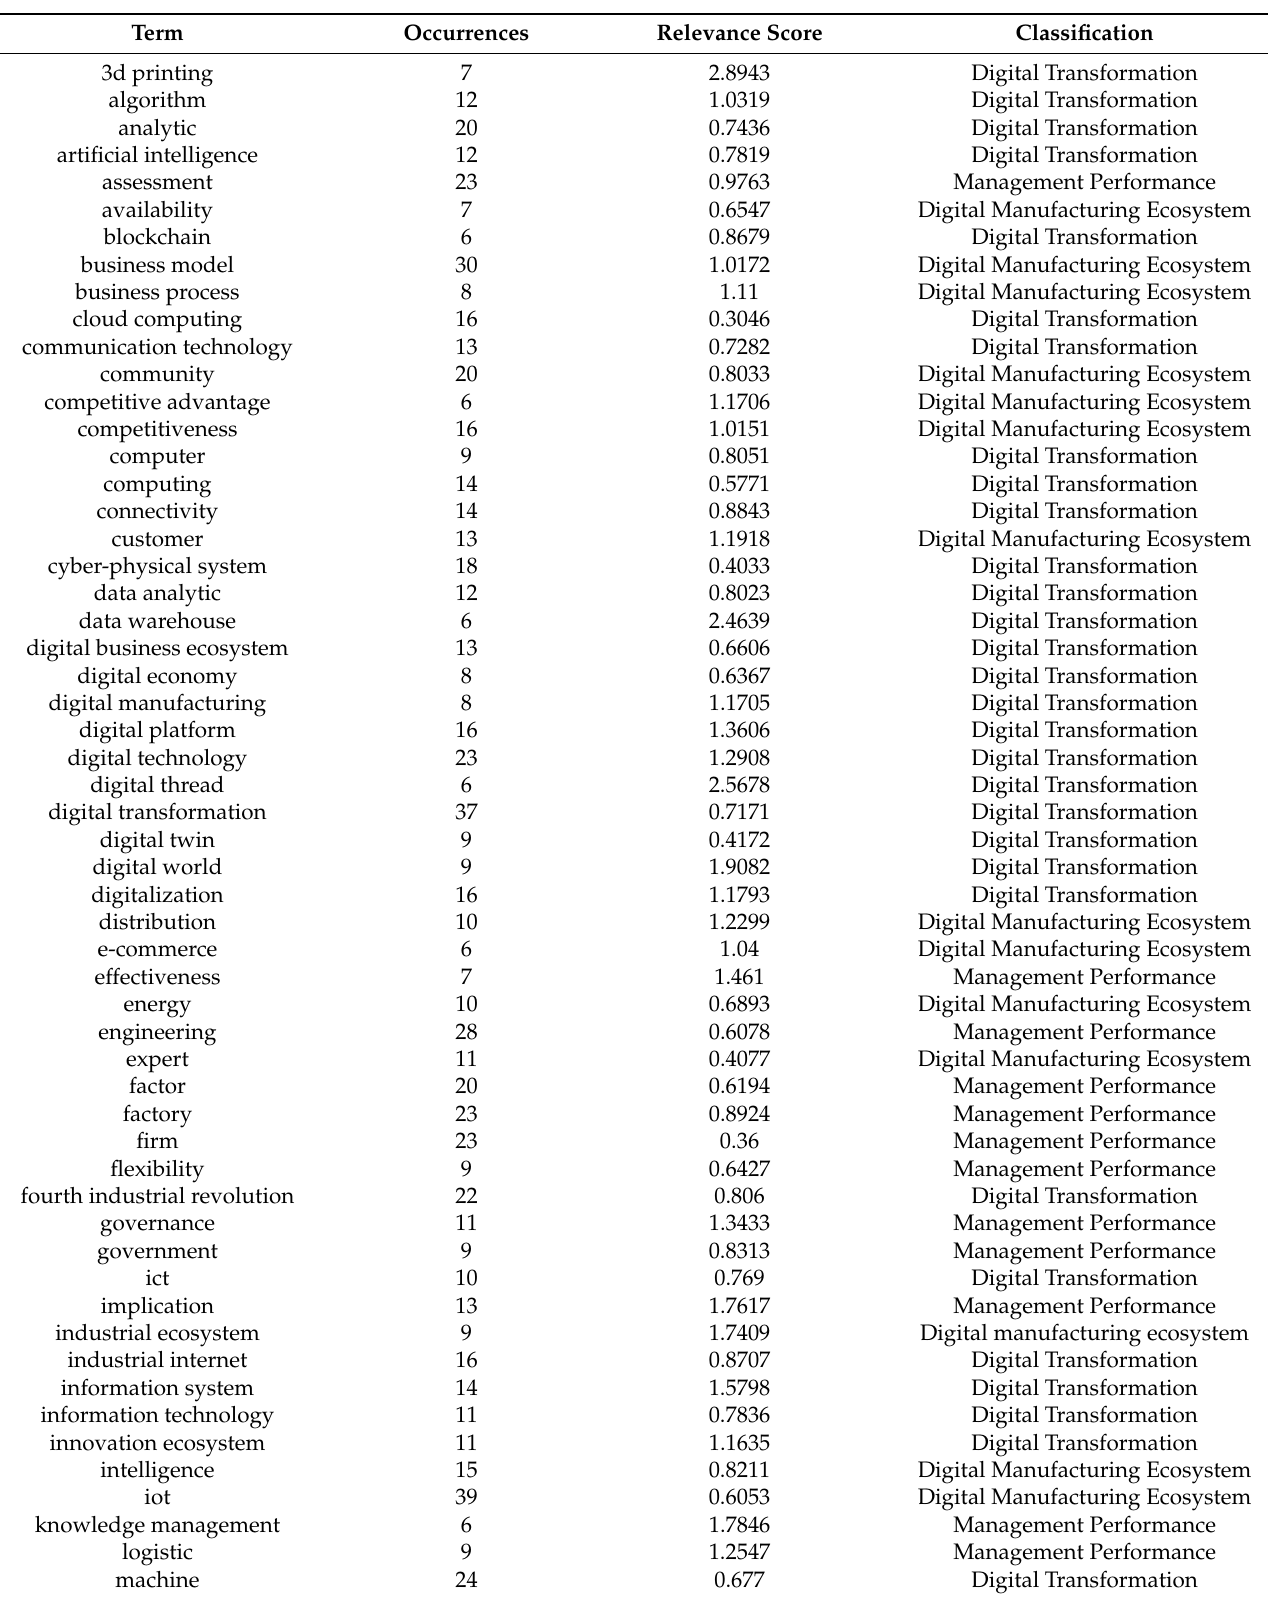
Table 1. Keyword occurrences and relevance